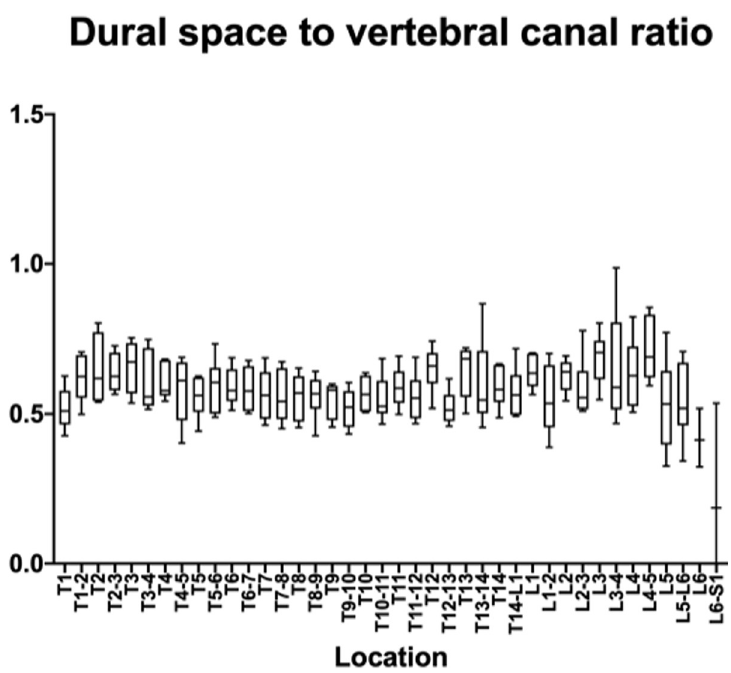
Fig 11. Graph of the dural space to vertebral canal ratio in 6 Yucatan sows. The median, 75 th , 25 th percentile and the range are shown for each thoracolumbar vertebral segment.